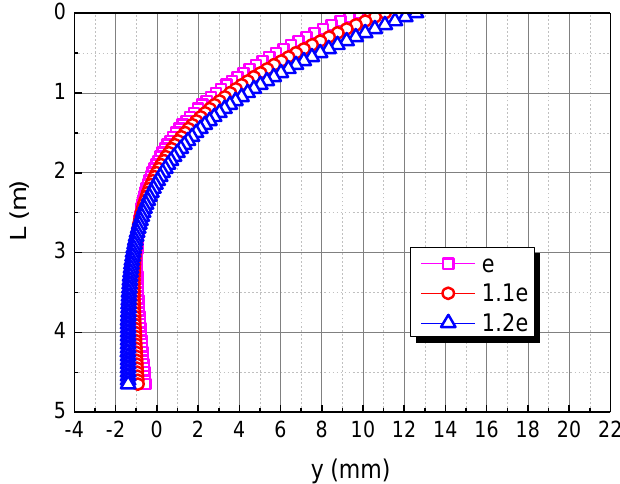
Figure 11. Effect of void ratio on horizontal displacement of pile in calcareous sand area.